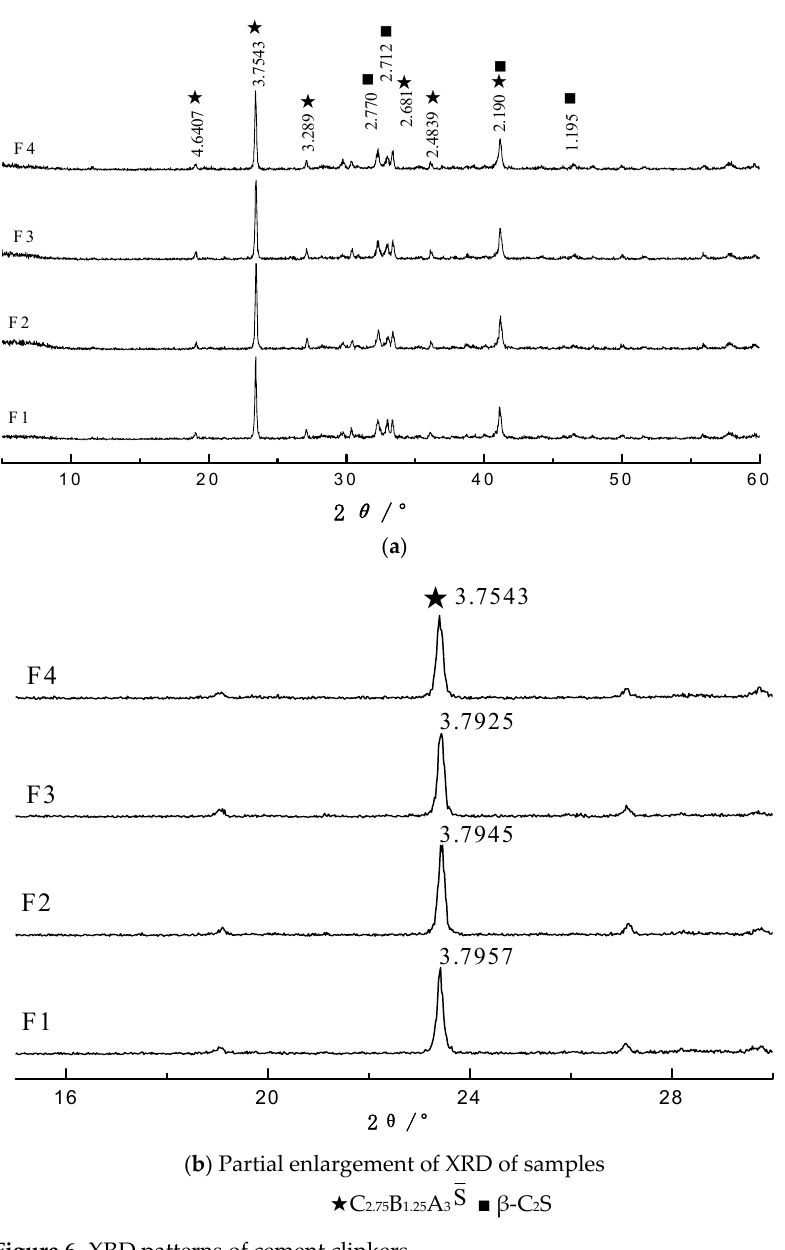
Figure 6. XRD patterns of cement clinkers.